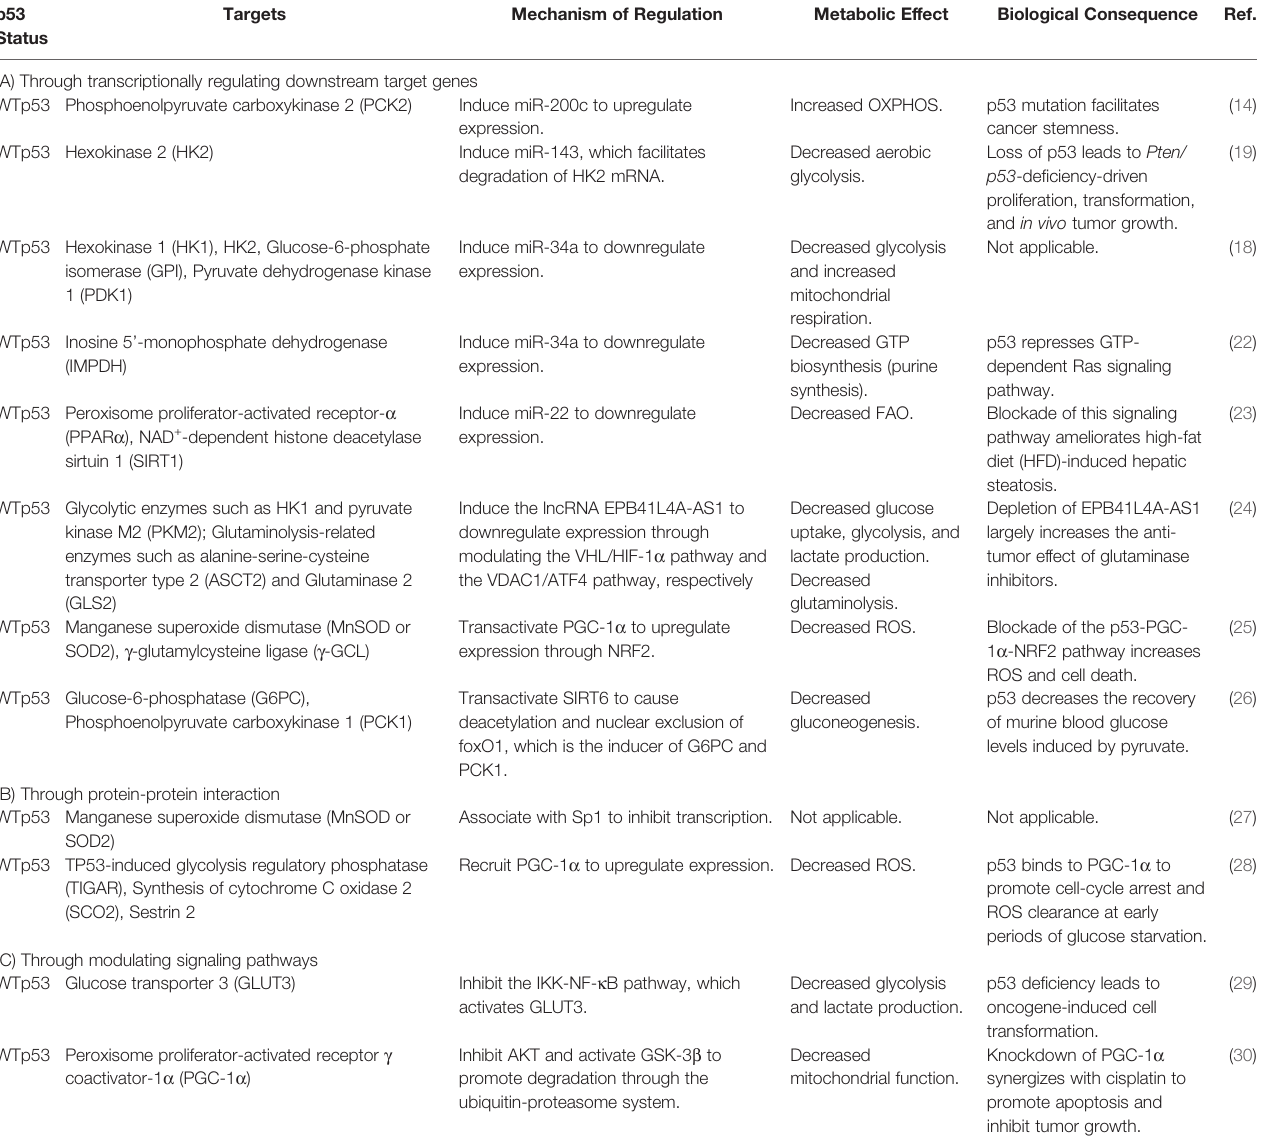
TABLE 1 | Metabolic targets indirectly regulated by wild-type